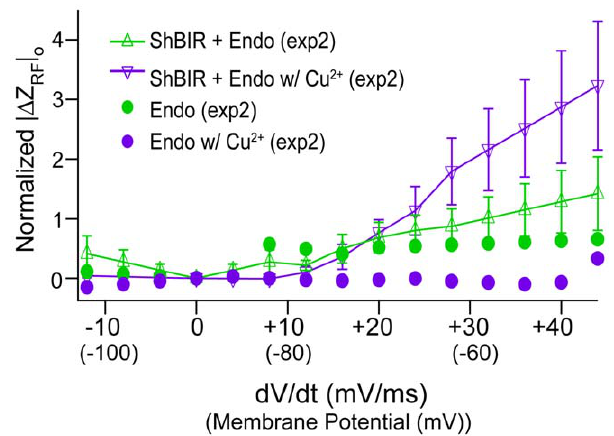
Figure 5. Onset RF Response in Sh B-IR Expressing Oocytes . Changes in RF impedance during the onset of voltage-clamp (| D Z RF | o, 0–1 ms after whole-cell depolarization) were slightly depressed in control oocytes with the addition of Cu 2 + (Cu 2 + -free - green markers, Cu 2 + addition - purple markers), but were significantly greater in Sh B-IR expressing oocytes (Cu 2 + -free - green line, Cu 2 + addition - purple